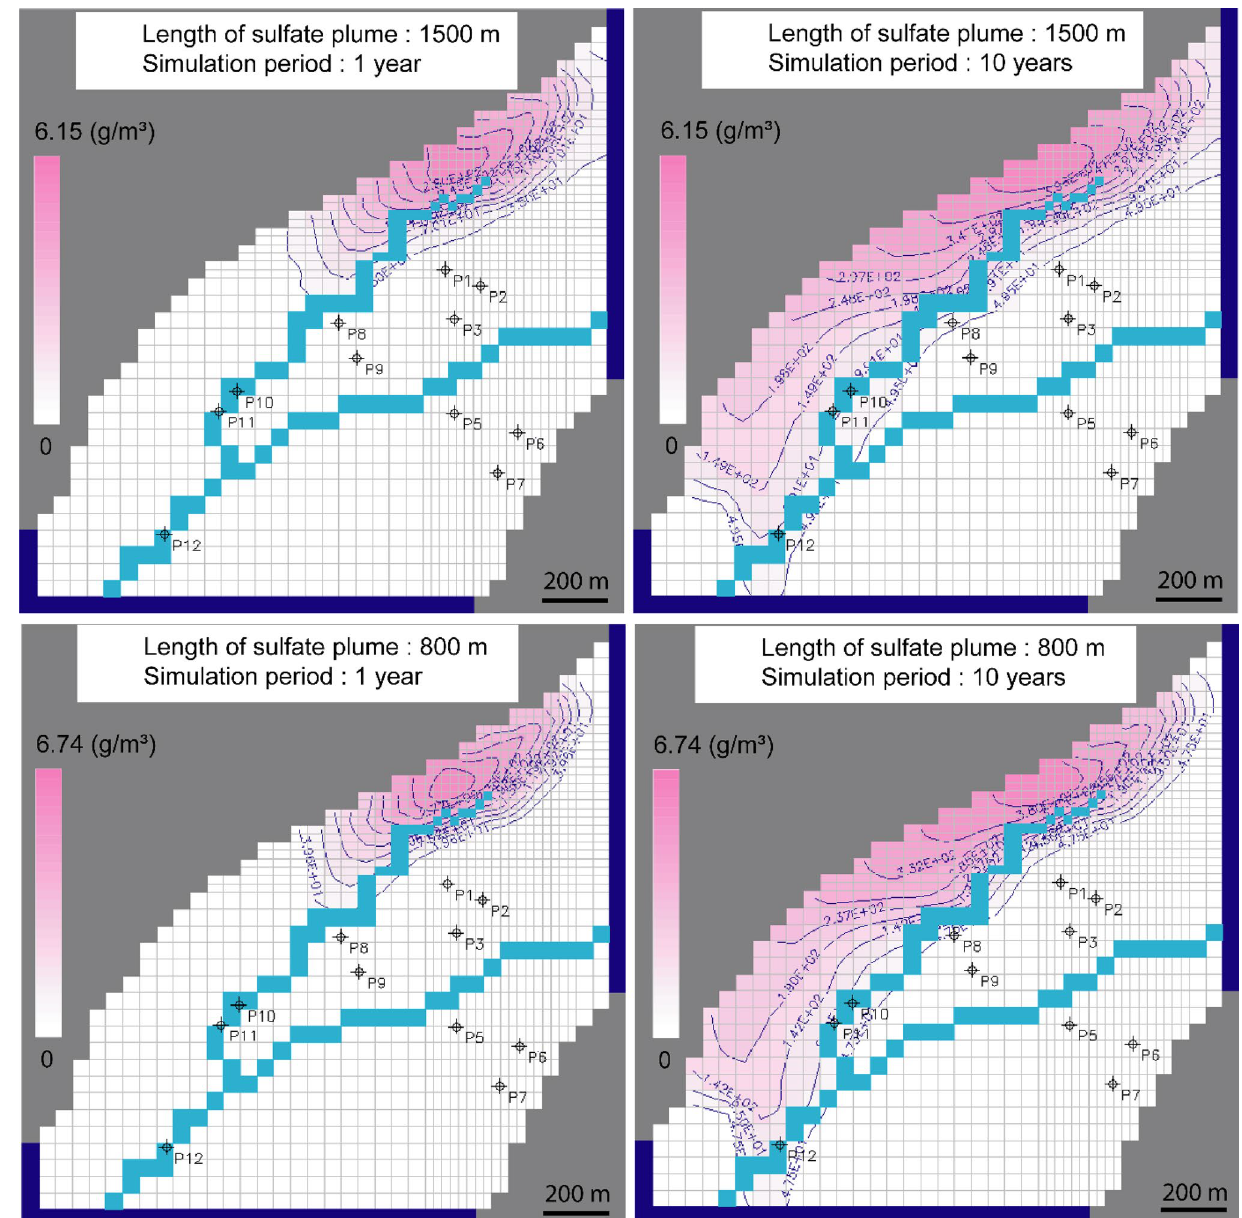
Fig. 10 Sulfate plume simulation assuming under remediation condition of scenarios 3 and